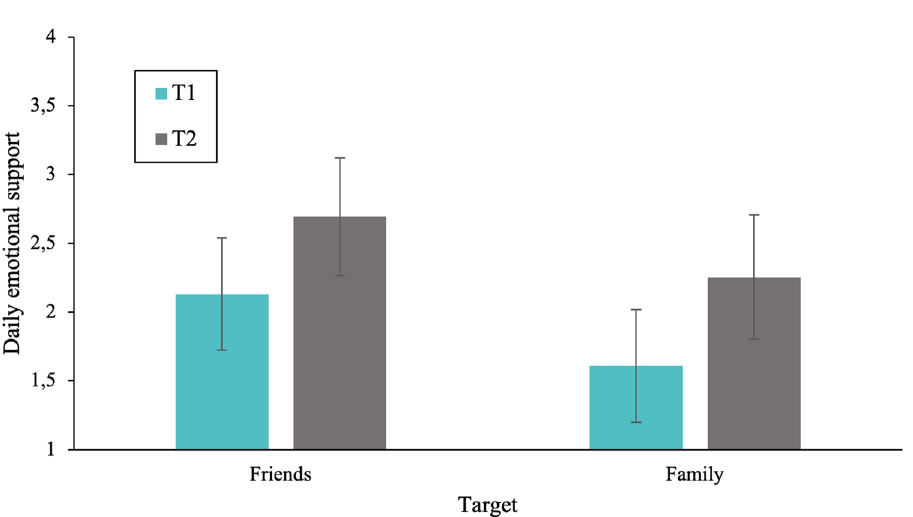
Figure 4. Mean levels of daily emotional support toward friends and family members at two timepoints (T1: May 2020 and T2: November 2020) during the COVID-19 pandemic. Adolescents showed an increase in daily emotional support from T1 to T2. Error bars denote 95% confidence